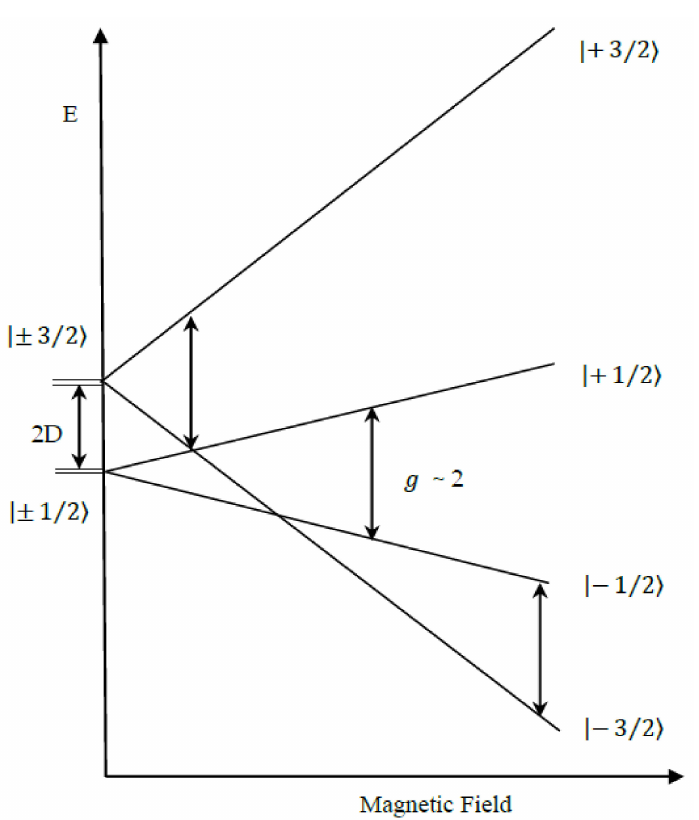
Figure 1. The axial spin 3 state ZFS and the Zeeman splitting when the field is parallel to the 2 molecular axis. The arrows indicate the microwave quantum energy E = h ν . Figure based on a diagram provided in Carrington et al.